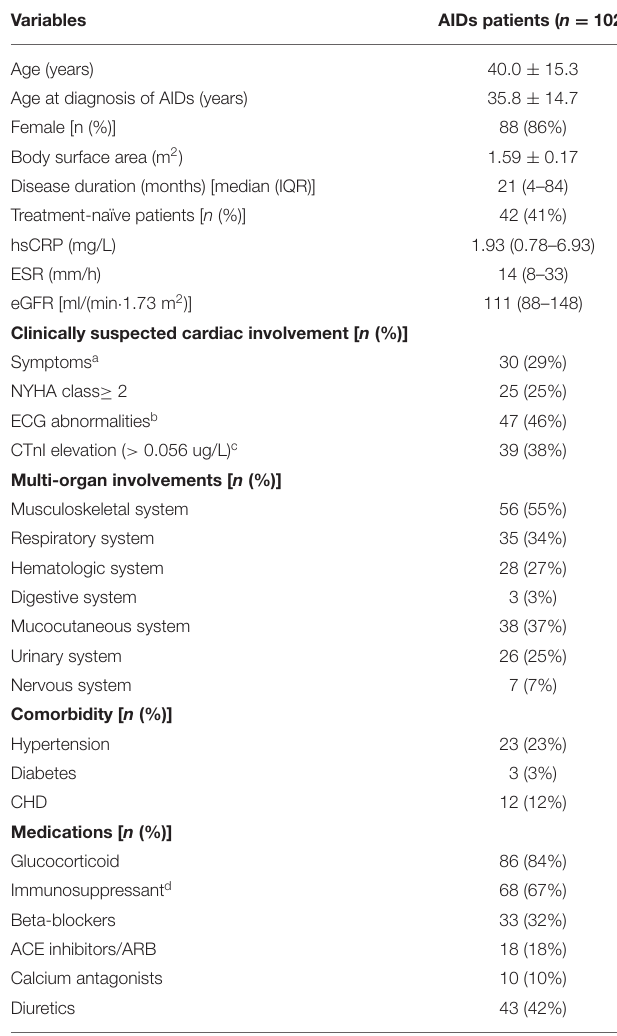
TABLE 1 | Baseline demographic and clinical characteristics of AIDs